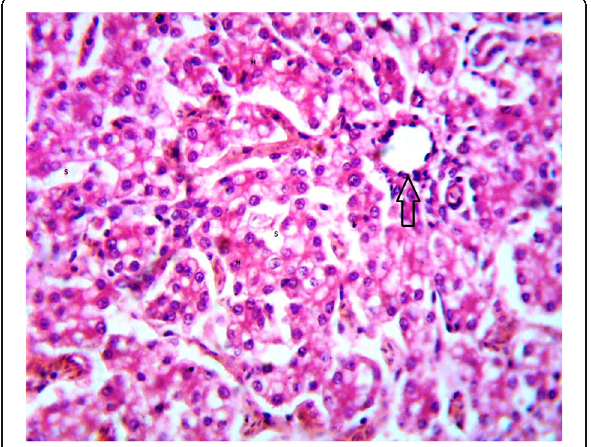
Fig. 6 Liver section of broiler chicken fed 8.0% of PCHM-inclusive diet showing marked infiltration of polymorphonuclear (star) cells around the vessel (arrow). Also seen is the activation of hepatic macrophage: Kupffer cells (arrow head). (H&E ×